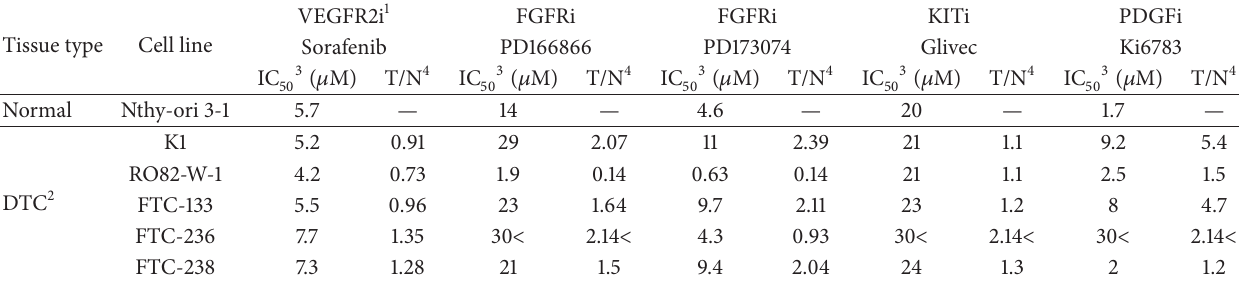
Table 2: In vitro antiproliferative activity of selective receptor tyrosine kinase inhibitors against human DTC cells.